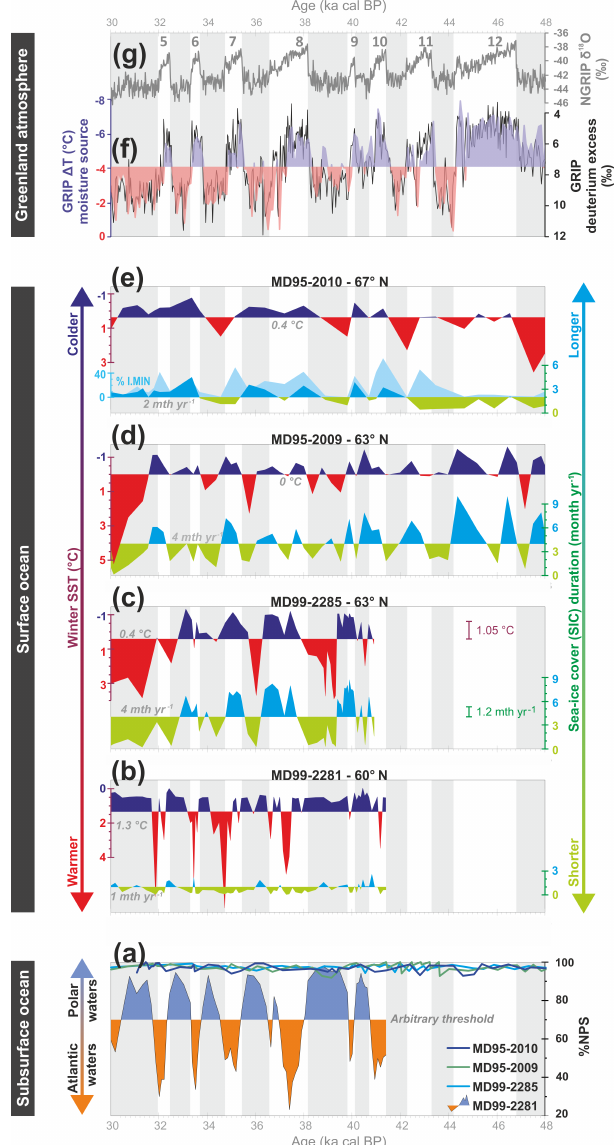
Figure 2. Proxy records. (a) %NPS (shading in MD99-2281 at an arbitrary threshold to better illustrate changes). (b–e) SST and SIC records, shaded relatively to the mean value (indicated in grey) of the parameter over the studied period. Error bars are shown in panel (c) . %I.MIN of MD95-2010 is also shown. (f) GRIP deu- terium excess record and associated reconstructed source tempera- ture anomaly (compared to modern value) of the evaporative source region for Greenland precipitation, assuming no change in humid- ity (Masson-Delmotte et al., 2005) (shaded relatively to its mean value over the studied period). (g) NGRIP δ 18 O (GICC05 age scale; North Greenland Ice Core Project members, 2004; Svensson et al., 2008). Grey bands highlight stadial